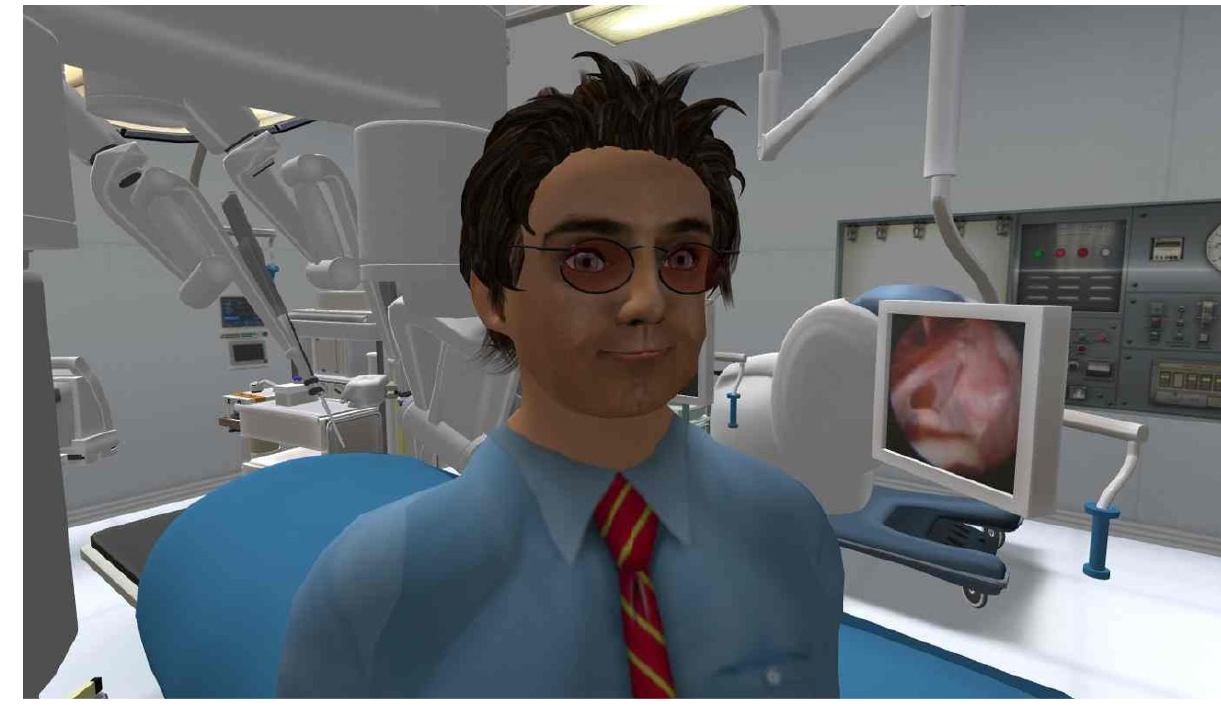
Figure 6. An avatar inside a virtual operating room in Second